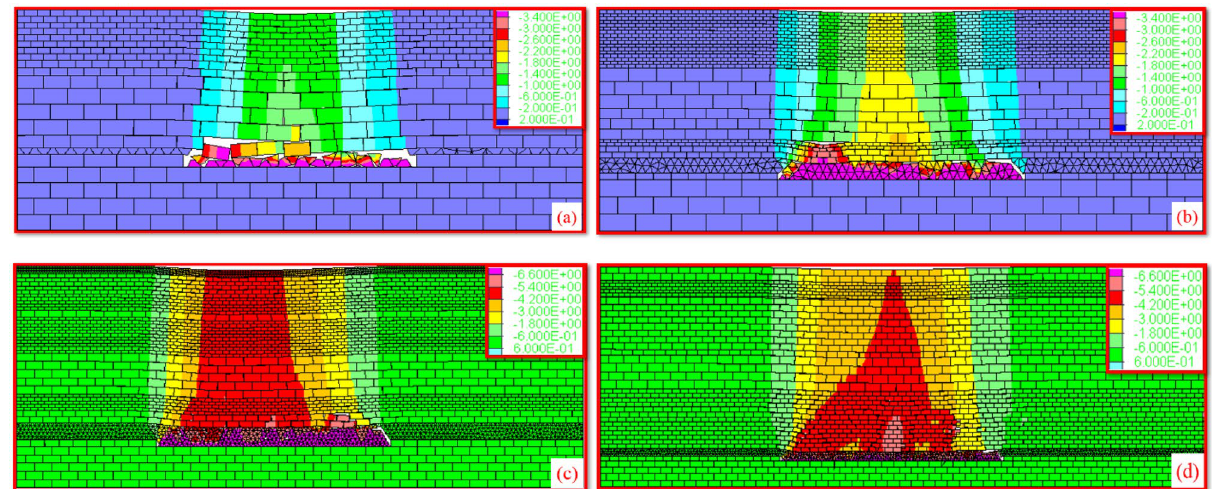
Figure 14. Displacement nephogram of overburden subsidence. ( a ) Subsidence coefficient 0.36. ( b ) Subsidence coefficient 0.47. ( c ) Subsidence coefficient 0.56. ( d ) Subsidence coefficient